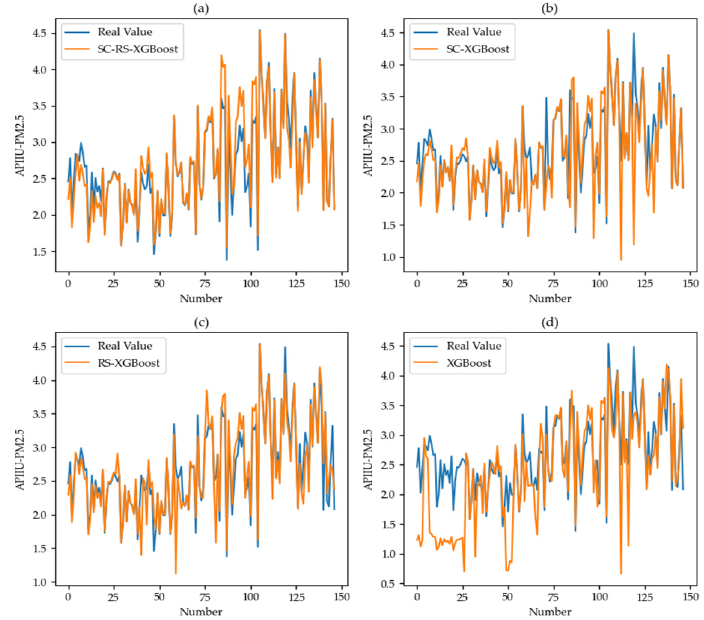
Figure A2. Comparison of real values and predicted values of APIIU-PM 2.5 from ( a ) SC-RS-XGBoost